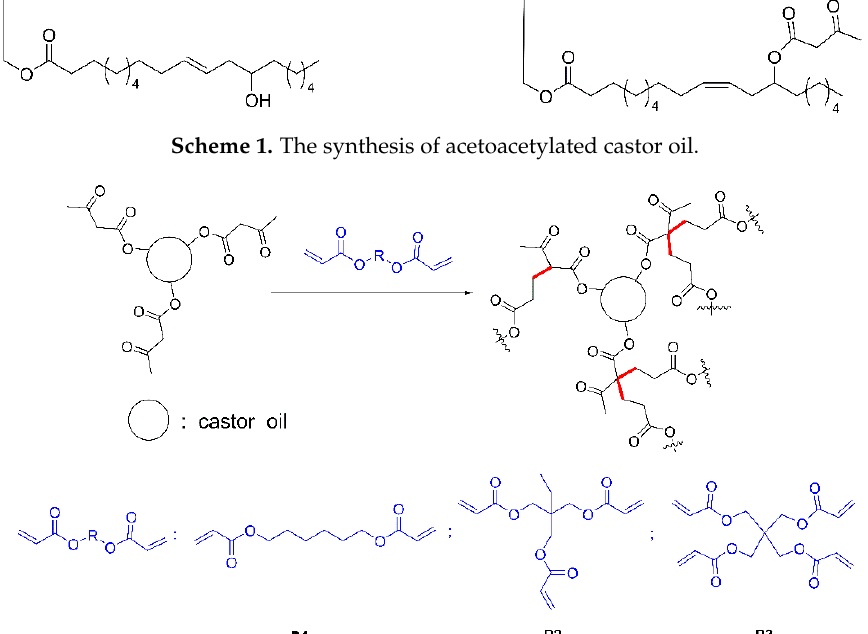
Table 1. Film codes and the ratio of materials of the Michael addition reaction.